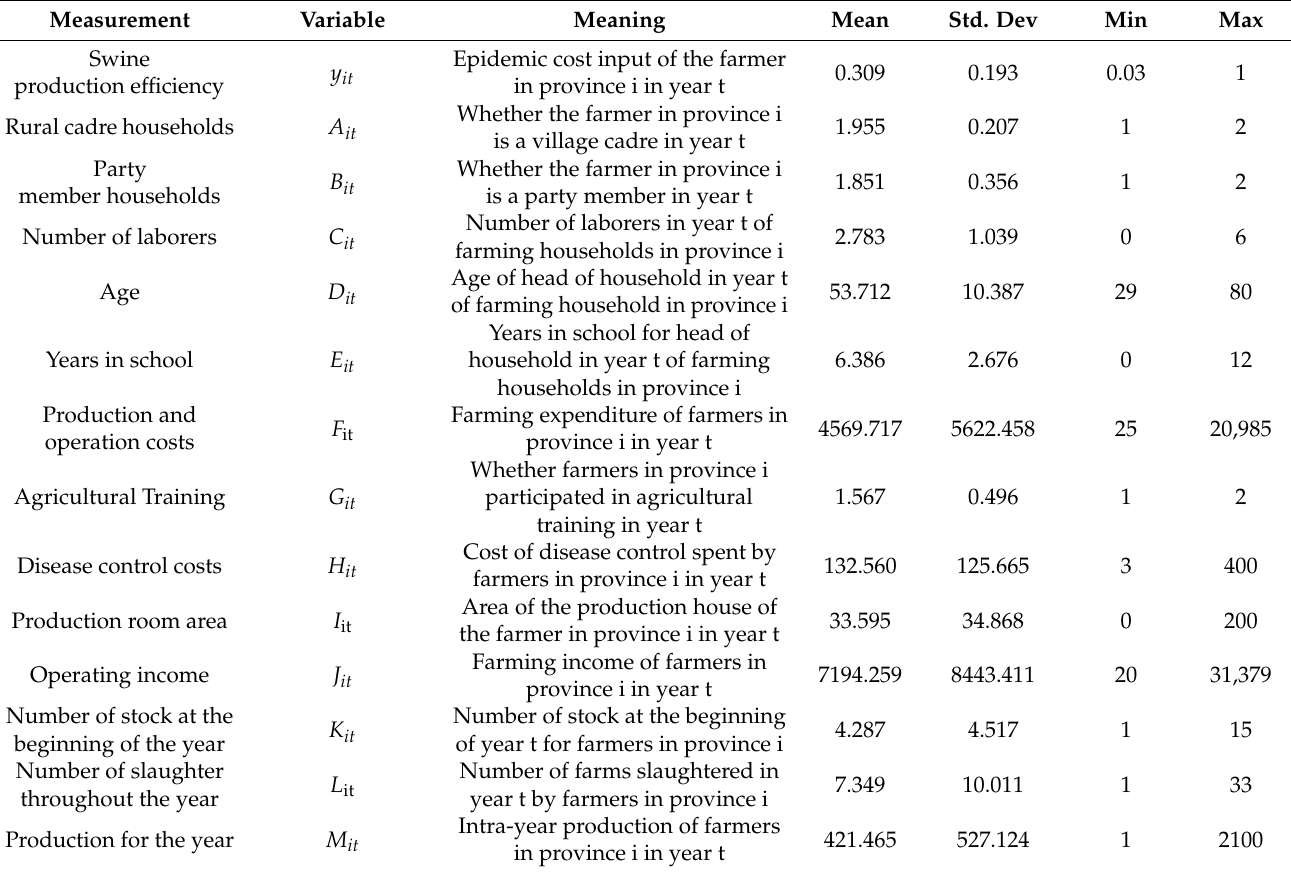
Table 1. Variables and results of descriptive statistical